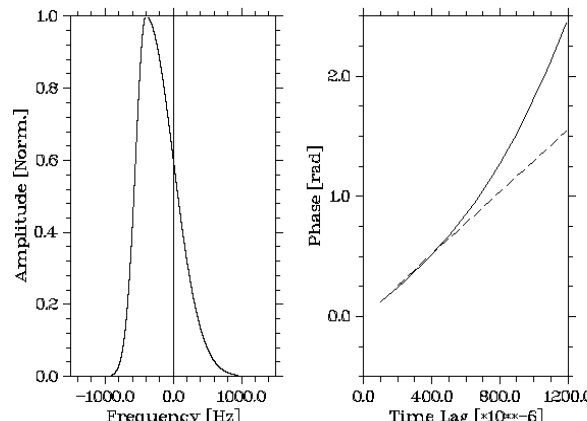
Fig. 1. (a) An asymmetric spectrum. Note, phase < 0. (b) The sim- a. An asymmetric spectrum. Note, phase<0. ulated experimental phase shift (Eq. 7) between two pulses trans- b. The simulated experimental phase shift (Equation 7) between two pulses mitted with a time lag of T is shown by the solid curve. The cal- transmitted with a time lag of T is shown by the solid curve. The calculations were made culations were made for the asymmetric power in (a). The dashed for the asymmetric power in Figure 1a. The dashed line represents the hypothetical phase line represents the hypothetical phase variation for a constant mean variation for a constant mean velocity equal to the mean Doppler velocity <f> derived velocity equal to the mean Doppler velocity <f > derived from from Equation 1 for the spectrum in Figure 1a. The slopes of the two curves are nearly Eq. (1) for the spectrum in (a). The slopes of the two curves are identical for small T, which means that the mean Doppler velocity and the experimental nearly identical for small T , which means that the mean Doppler velocity are compatible for small time lags, in this case close to |220 m/s|. velocity and the experimental velocity are compatible for small time lags, in this case close to | 220m/s |